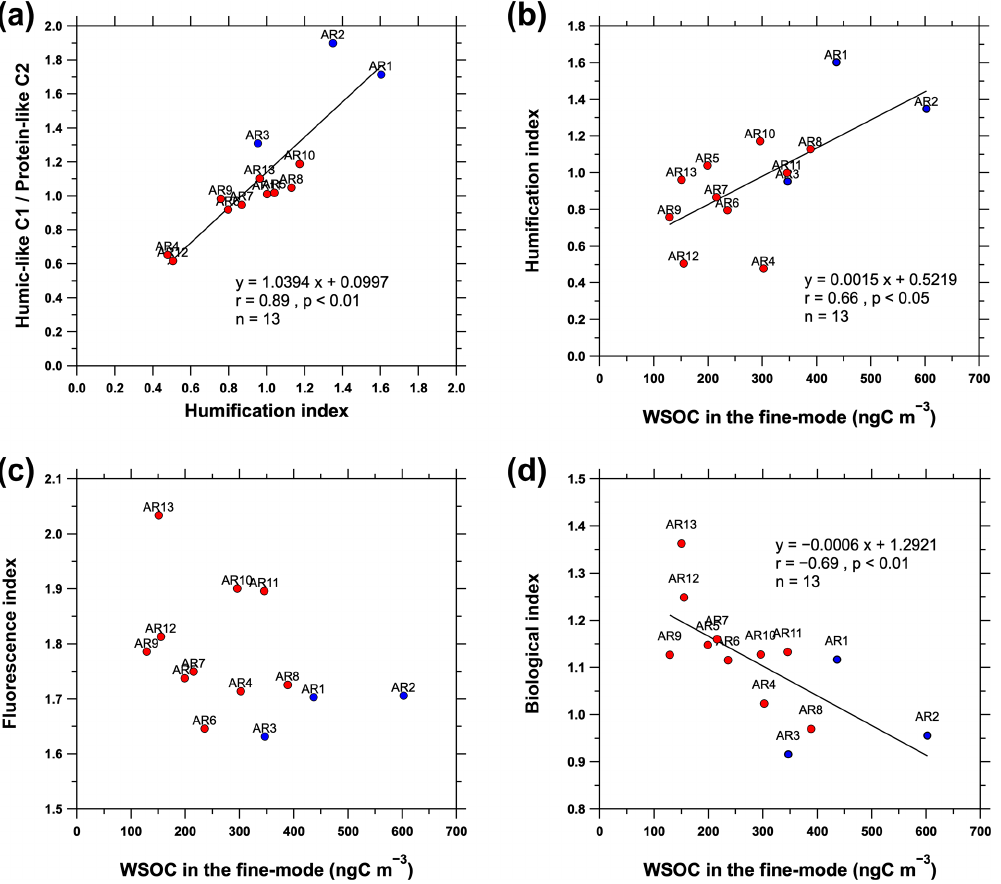
Figure 8. (a) Relationship between the fluorescence intensity ratio of the humic-like C1 / protein-like C2 with humification index (HIX). Relationships between WSOC concentration in the fine-mode aerosols and (b) HIX, (c) fluorescence index (FI), and (d) biological index (BIX). The solid blue and red circles indicate the samples collected from the coastal and sea-ice-covered areas,